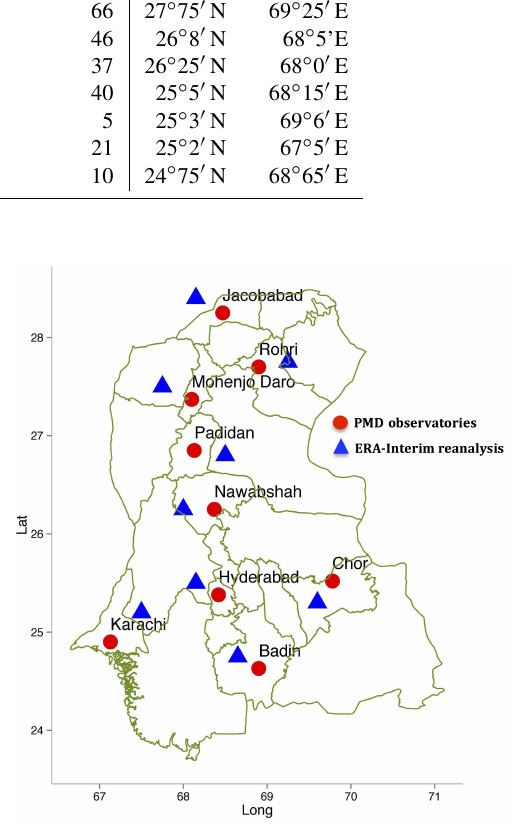
Figure 1. Study domain (23.5–28.5 ◦ N , 66.5–71.1 ◦ E).